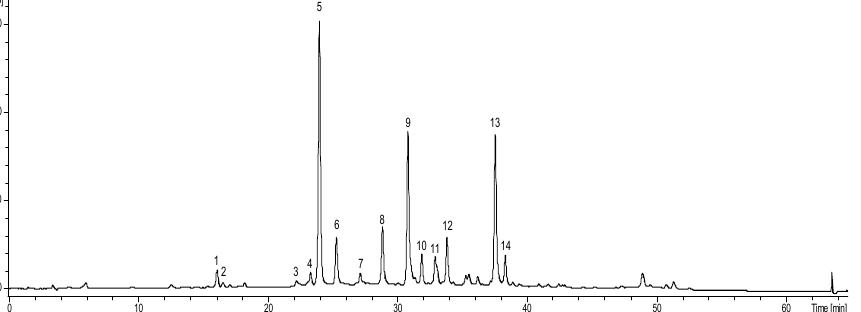
Figure 1. Total ion chromatogram generated by LC-EM (270 nm) of the Hydroalcoholic Crude Extract of Vernonanthura brasiliana (EB Vb ).